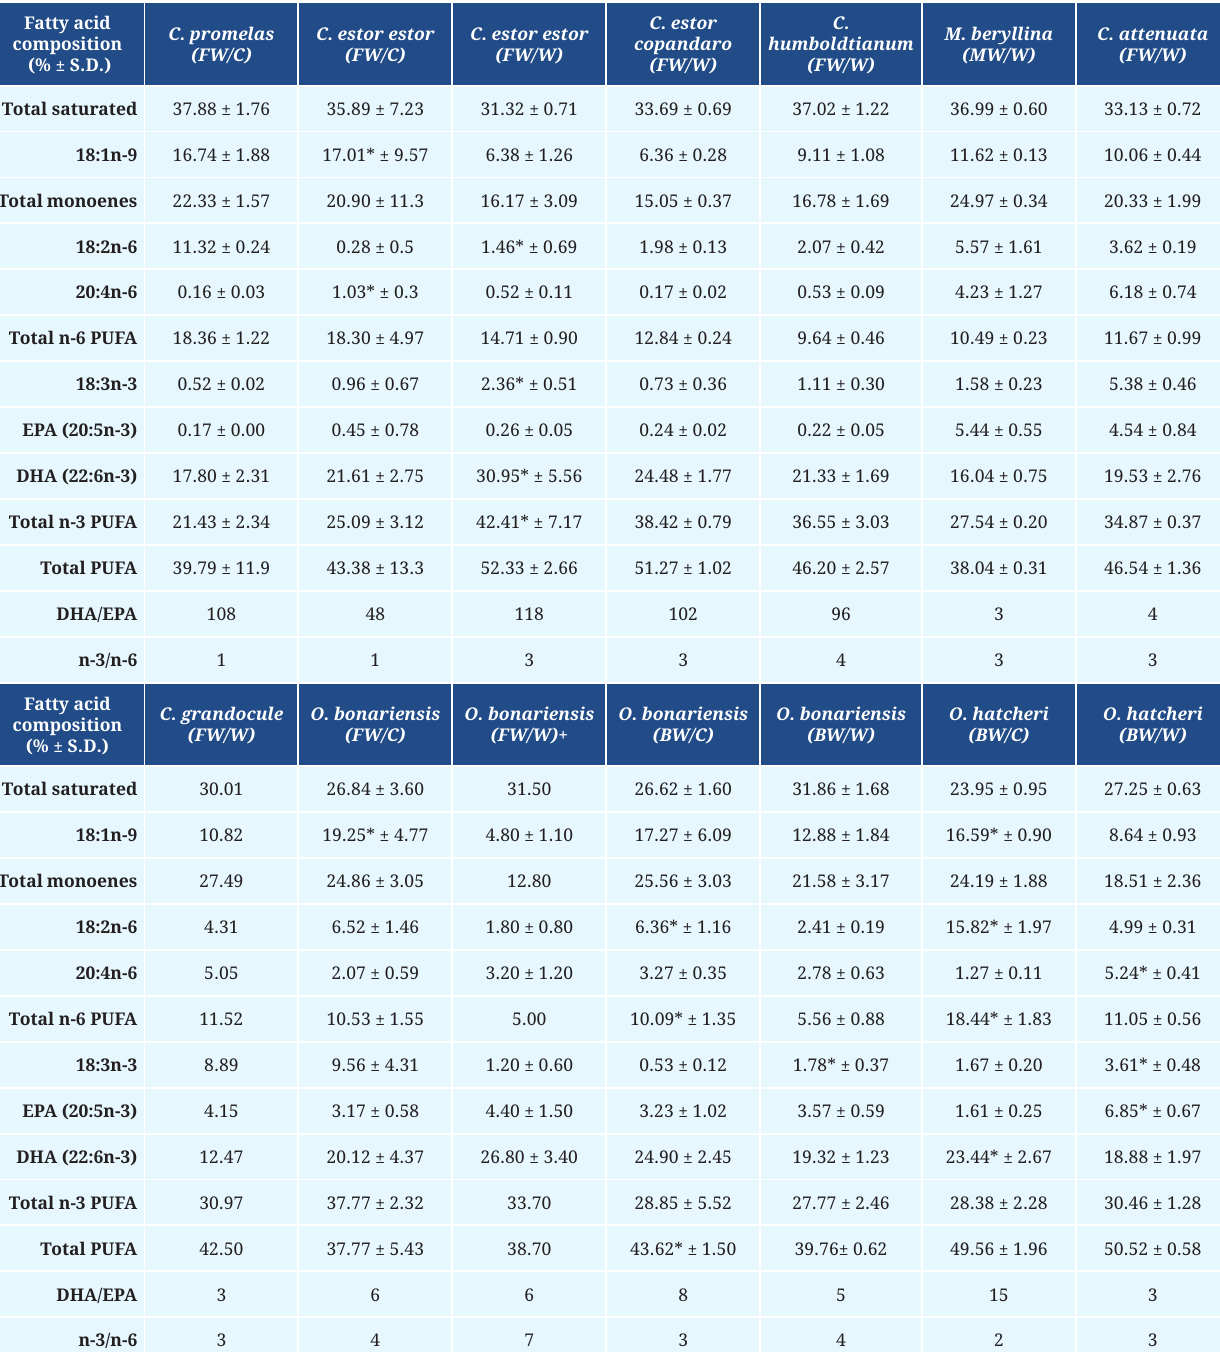
TABLE 1 | Composition and ratios of the most important fatty acids (percentage of total fatty acids by weight) of total lipid of flesh in members of the Atherinopsidae family: Chirostoma grandocule , C. attenuata , C. estor , C. promelas , C. humboldtianum , Menidia beryllina , Odontesthes bonariensis and O. hatcheri